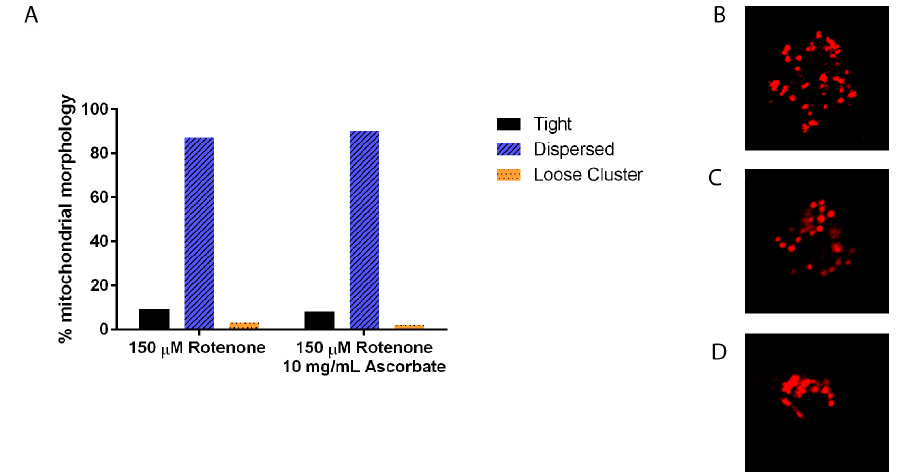
Figure 7. Mitochondrial morphology in cells treated with rotenone and 0 mg/mL or 10 mg/mL of ascorbate acid. ( A ) There was no significant morphology difference in mitochondria treated with ascorbate acid than rotenone treatment alone ( n ≥ 80). Standard error is indicated by error bars. ( B ) Example of fully dispersed mitochondria, ( C ) loose cluster, and ( D ) tight clusters of mitochondria.